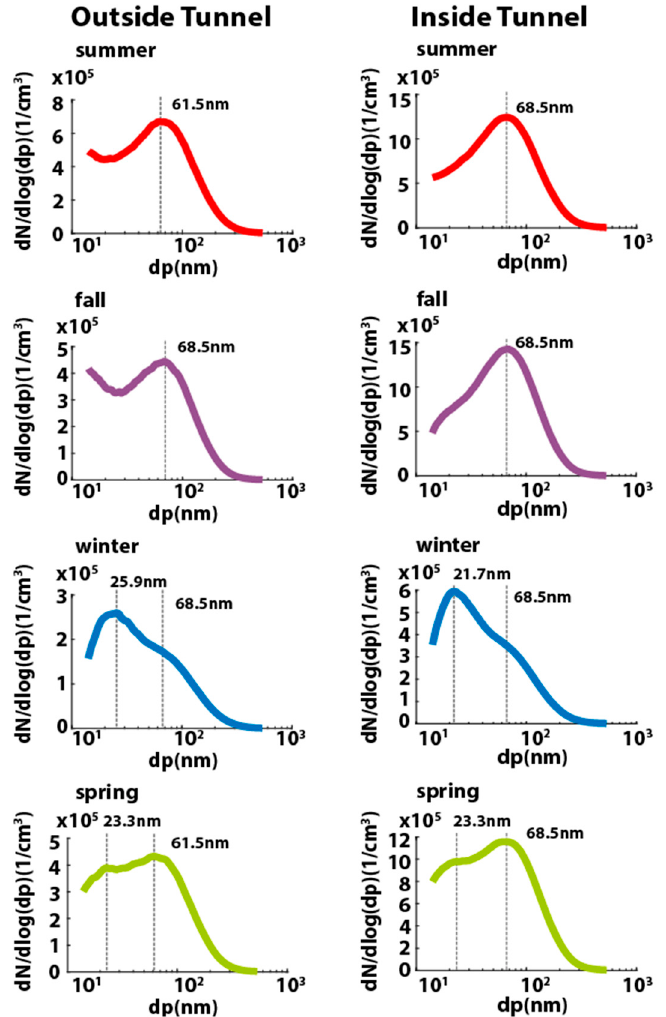
Figure 5. Overall averaged seasonal particle size distribution in the inside and outside of the tunnel estimated by using SMPS.